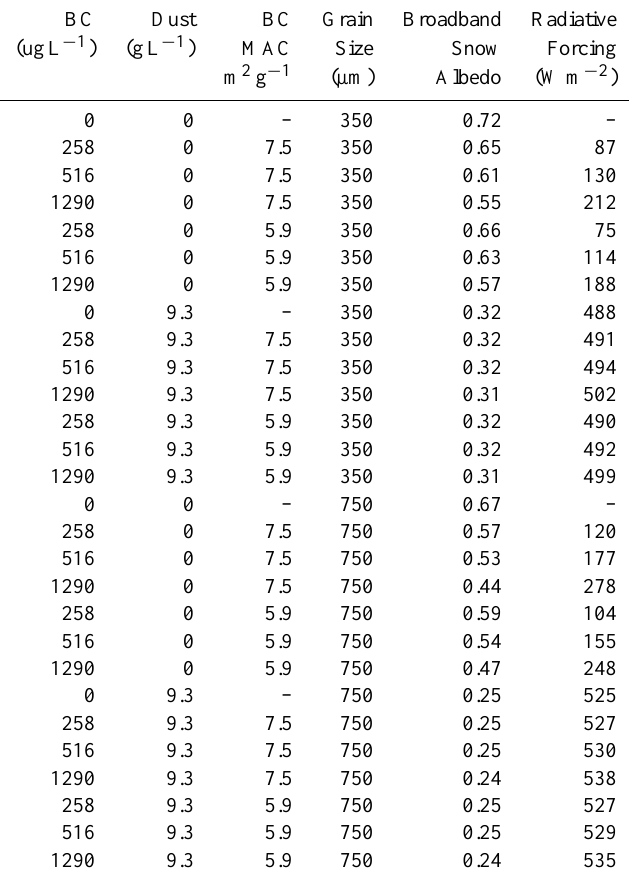
Table 3. SNICAR modeled broadband snow albedo and SBDART modeled radiative forcing (Wm − 2 ) based on BC and dust concentrations in the surface layer at Mera La, and assumed BC MAC and snow grain size. BC = 258µgL − 1 is based on M BC, whereas BC = 516µgL − 1 and 1290µgL − 1 are M BC × 2 and M BC × 5 scenarios used to bracket the plausible upper range in BC concentrations at the